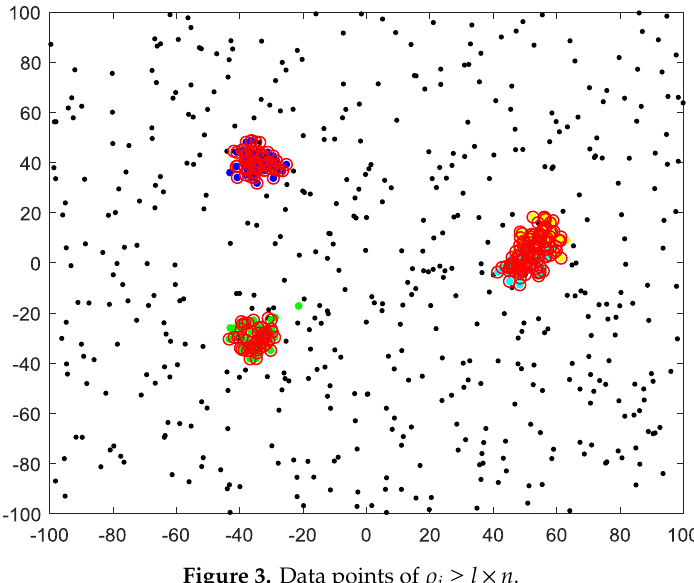
Figure 3. Data points of